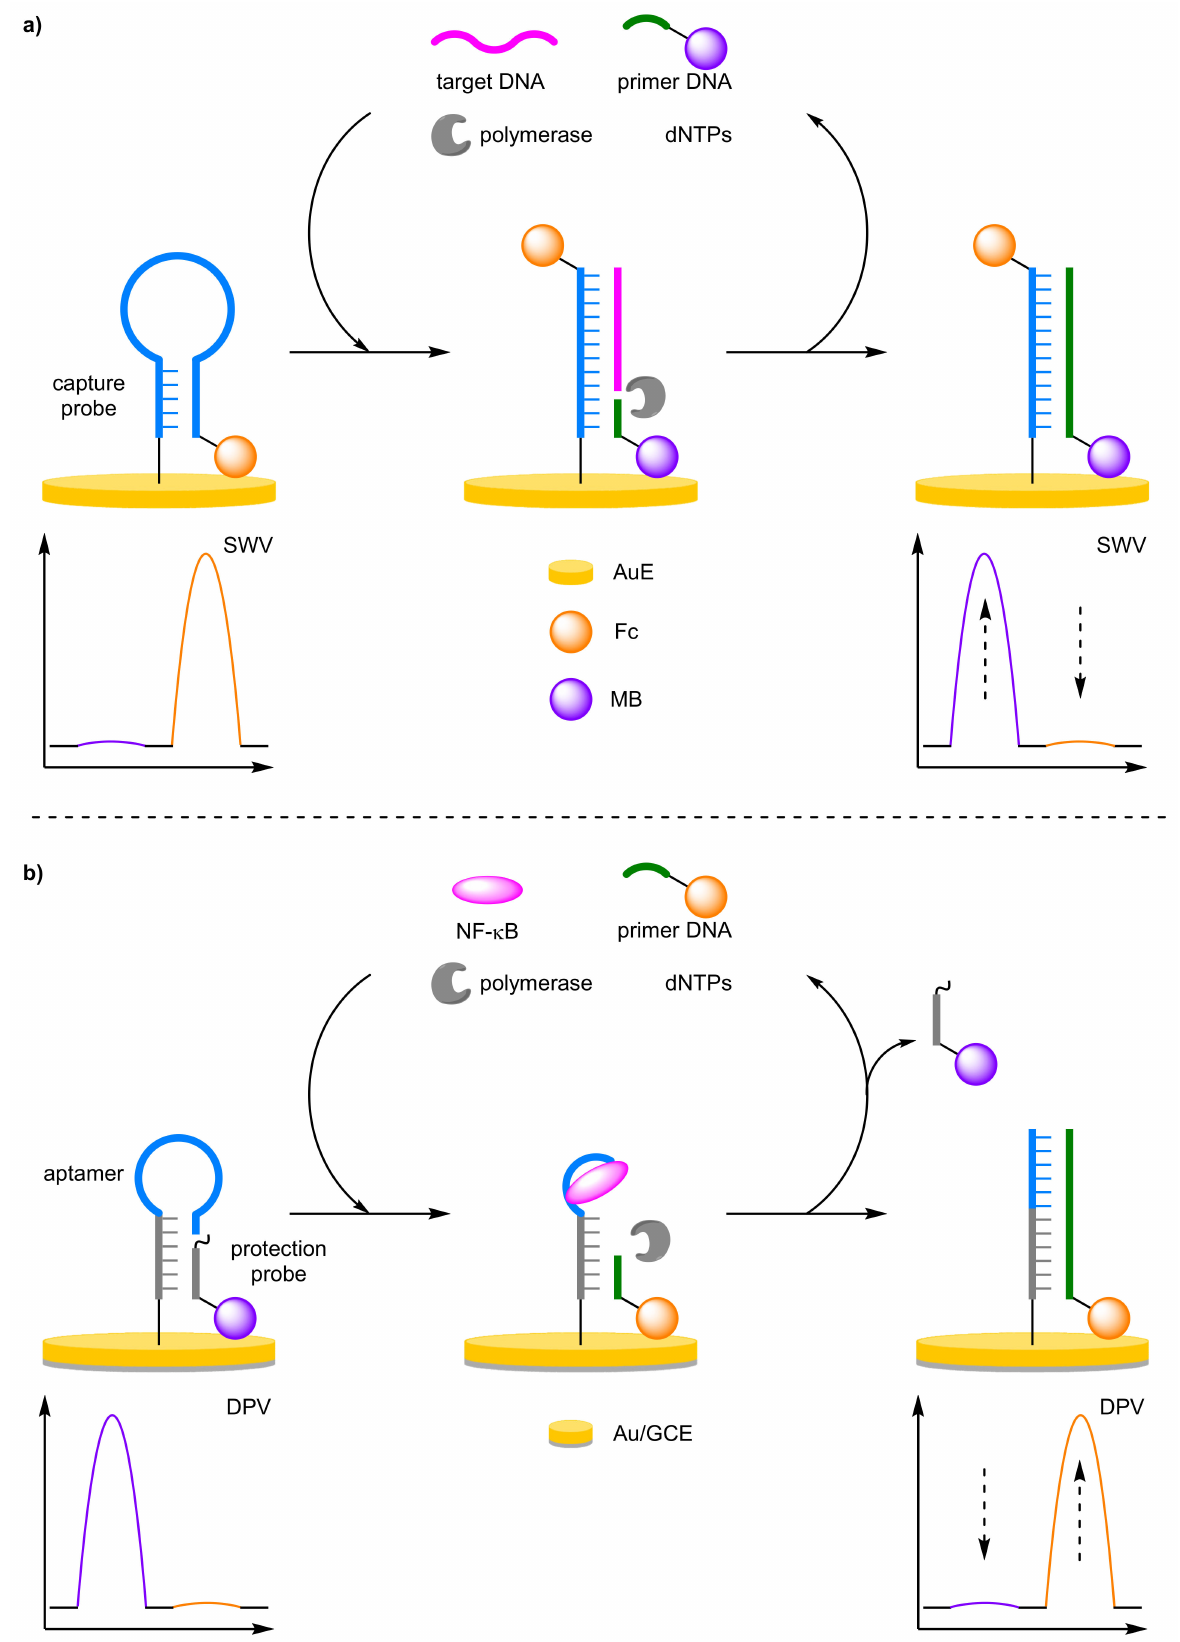
Figure 16. Schematic representation of two polymerase-base target amplification biosensor: ( a ) for target DNA; ( b ) an aptasensor for NF- κ